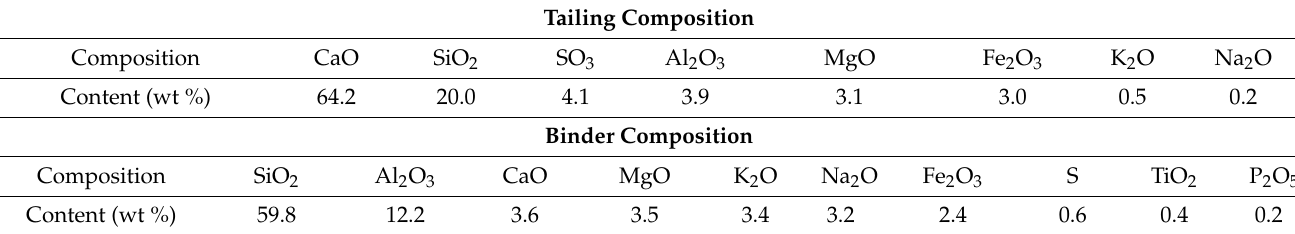
Figure 1. Grain size distribution. Table 1. Minerology and composition